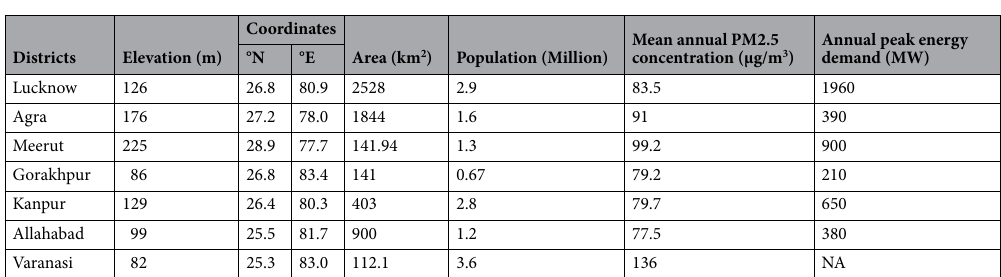
Table 2. Geographical location and key facts of all the cities. NASA data & Uttar Pradesh: Uncovering solar rooftop potential in urban cities 5 .